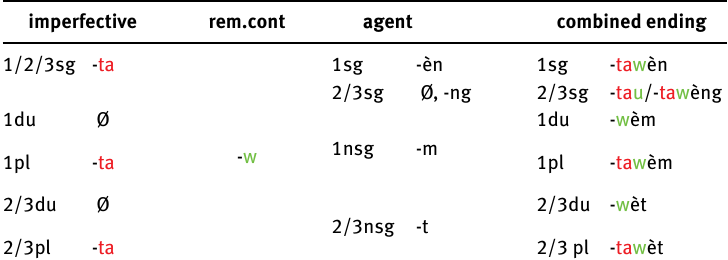
Table 6: Remote continuous